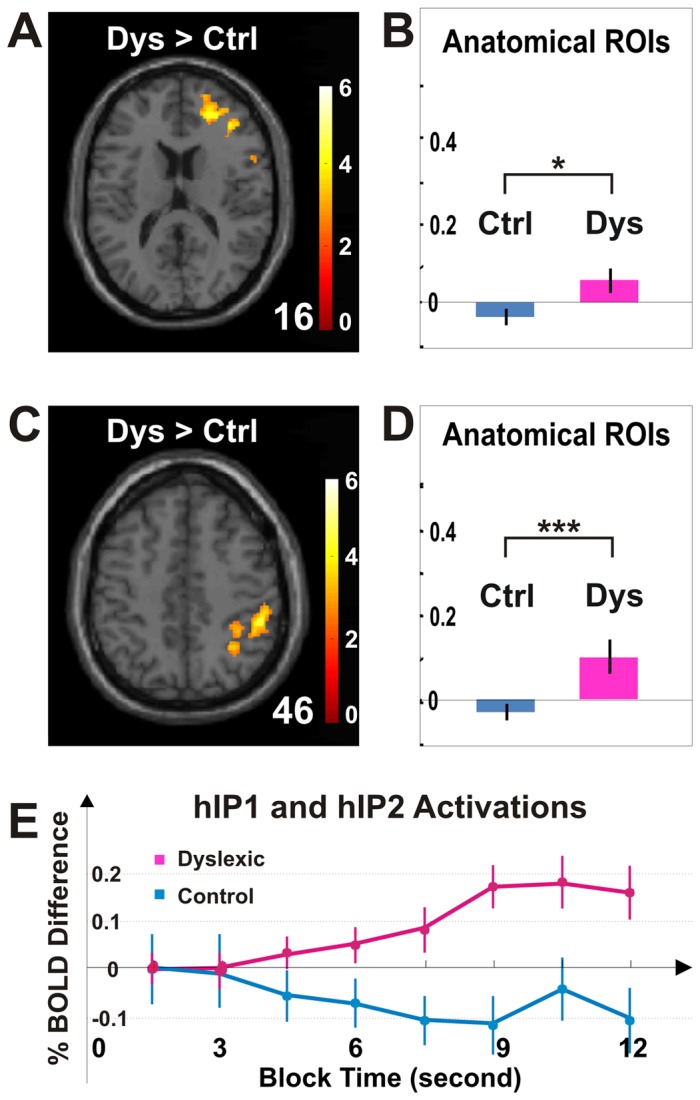
Hyperactivation for dyslexia in fronto-parietal regions.(A) The brain image illustrates frontal voxels that exhibited significantly greater activation for the dyslexic group than for the control group (Dyslexic>Control, p<0.05, cluster corrected for frontal lobe, shown at 16 mm above the AC-PC level). (B) Anatomically determined ROI analysis shows that frontal activation for the dyslexic group was significantly greater than for the control group. (C) The brain image illustrates parietal voxels that exhibited significantly greater activation for the dyslexic group than for the control group (Dyslexic>Control, p<0.05, cluster corrected for parietal lobe). (D) Parietal activation for dyslexic group was significantly greater than the control group. (E) The activation time course for anatomically determined areas hIP1 and hIP2 showed greater parietal activation for the dyslexic group than for the control group. * p<0.05; *** p<10−6; main effect of group in two-way ANOVA for group and area. Error bars indicate SEM within group.